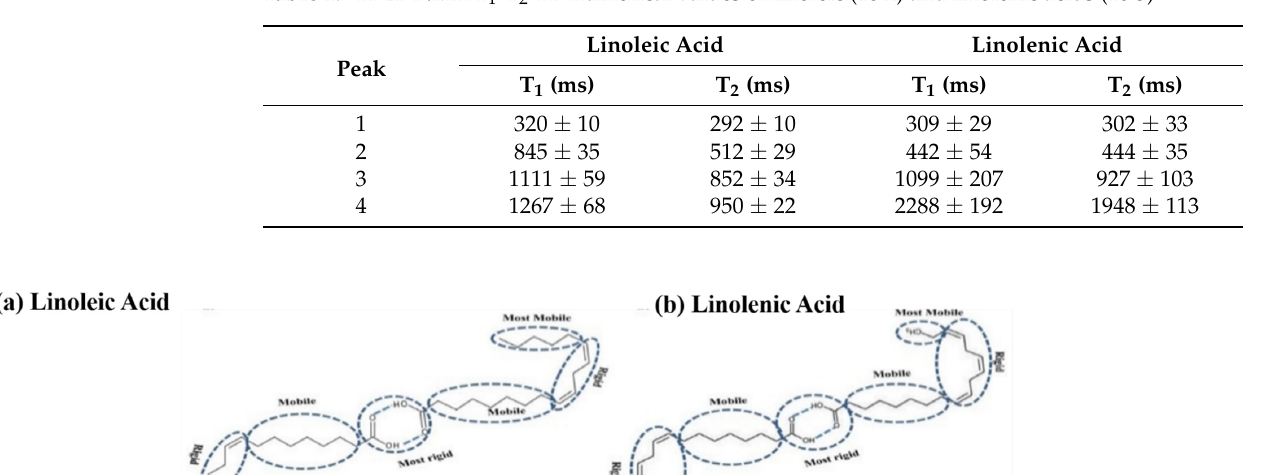
Table 1. 1 H LF NMR T 1 -T 2 TD numerical values of linoleic (18:2) and linolenic acids (18:3).